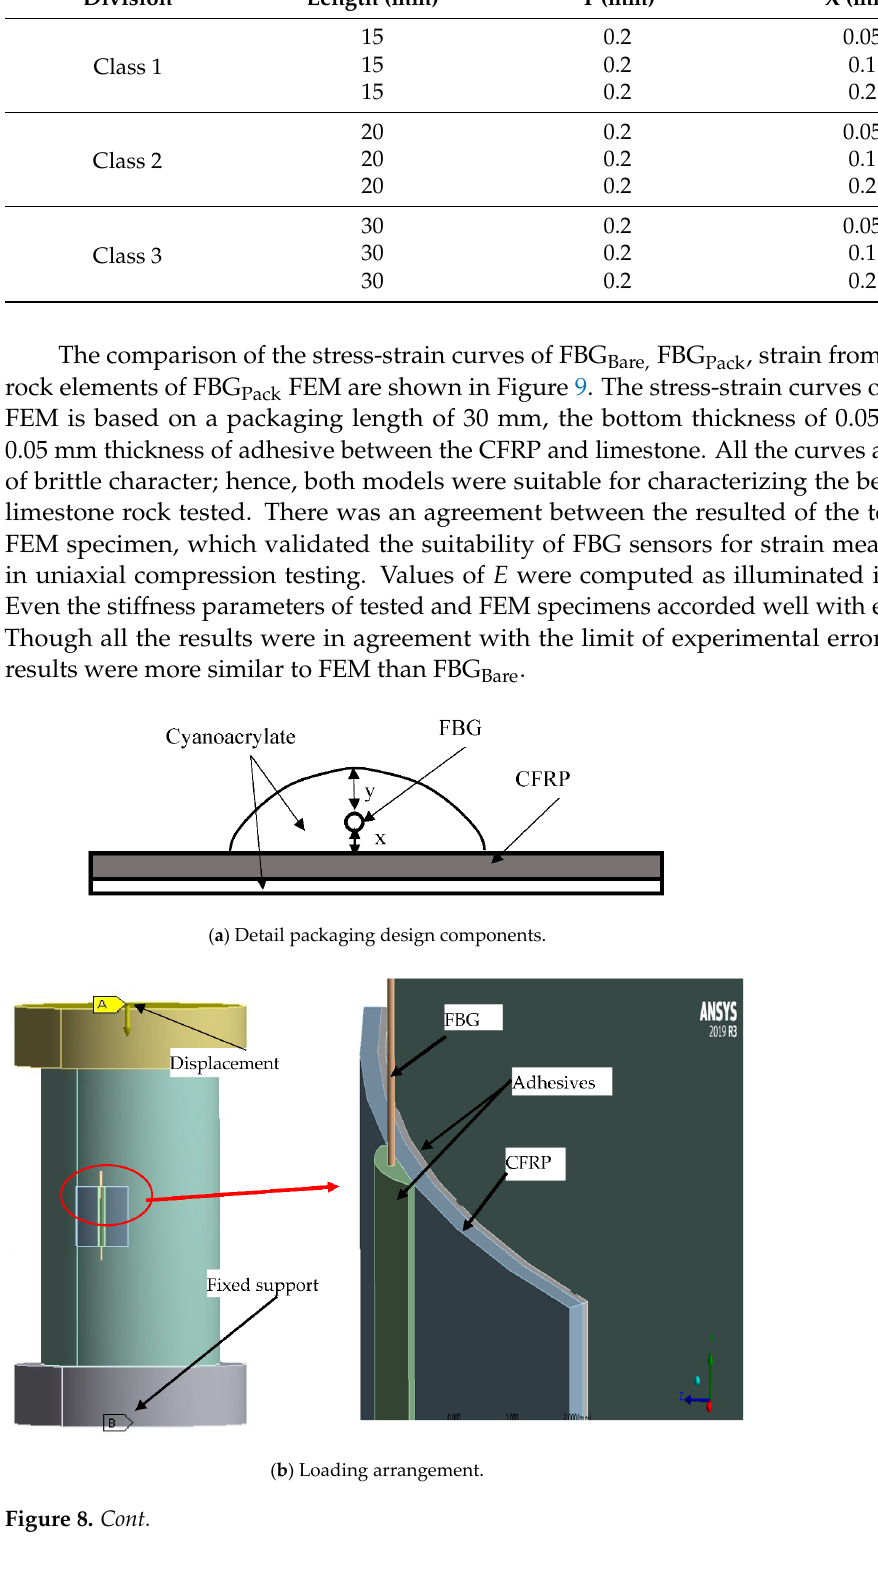
Table 6. FBG Pack specification for FEM analysis.